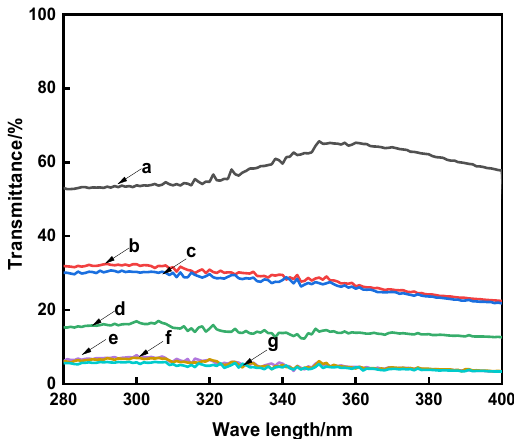
Figure 5. The UV transmittances of the cotton fabrics (a, Raw; b, Direct; c, Mordant; d, CA; e, CA+TTA; f, CA+MLA; g, CA+SUA). Table 7. The UPF values of the raw, direct, mordant, and cross-linked dyed cotton fabrics.